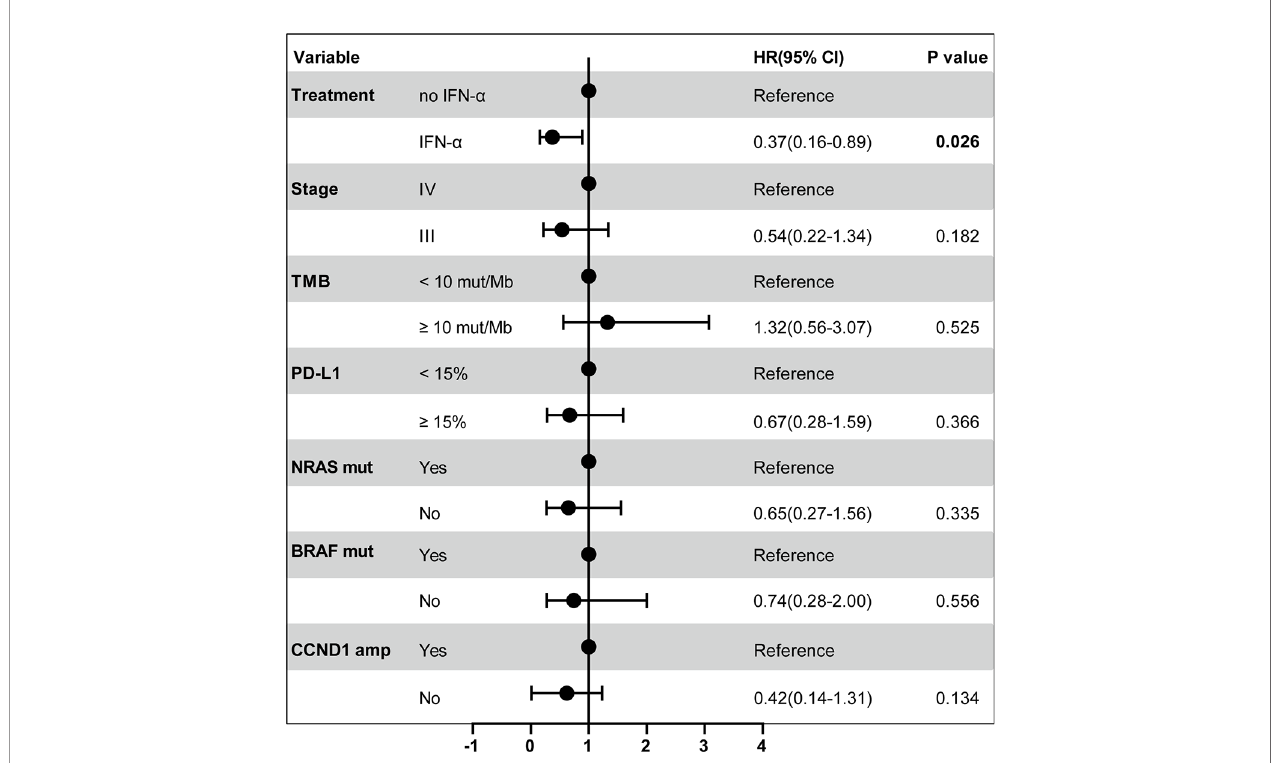
FIGURE 3 | Forest plot of RFS Pem according to the prespeci fi ed subgroups. The multivariable Cox proportional-hazards model was used to estimate the hazard ratios for the risk of recurrence after adjuvant pembrolizumab among all patients. The solid circle indicates hazard ratio (HR) for the risk of recurrence. The bar represents the 95% con fi dence interval (CI) for each HR. The P value for the comparison is also